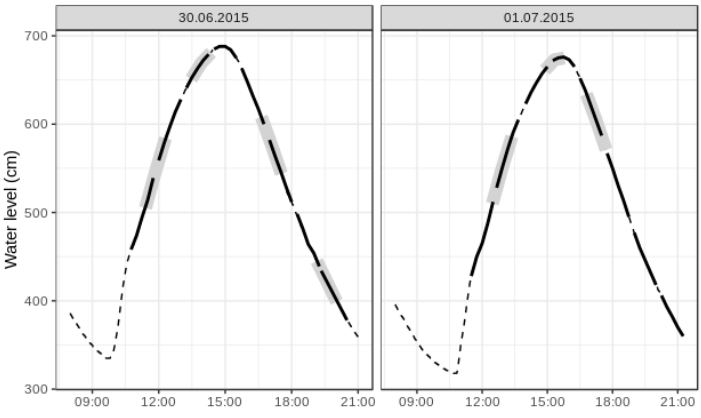
Figure 2. Flight times for hexacopter (solid black line) and gyrocopter (thick grey line) as well as water level (slashed black line) in the survey area at the Hahnöfer Nebenelbe.